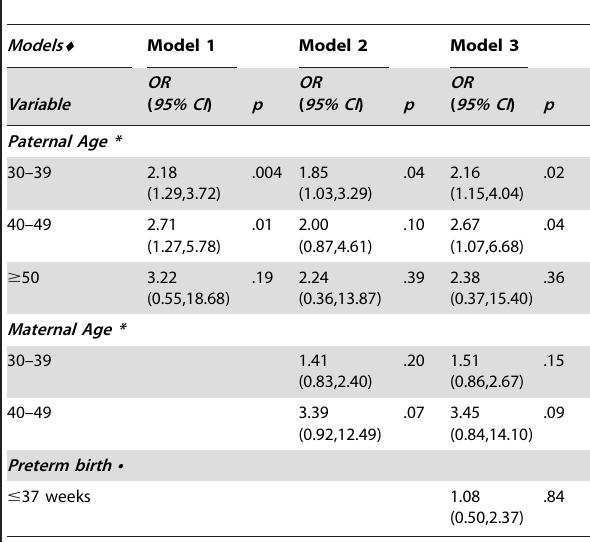
Table 2. Odds ratios for paternal age adjusted for maternal age and preterm